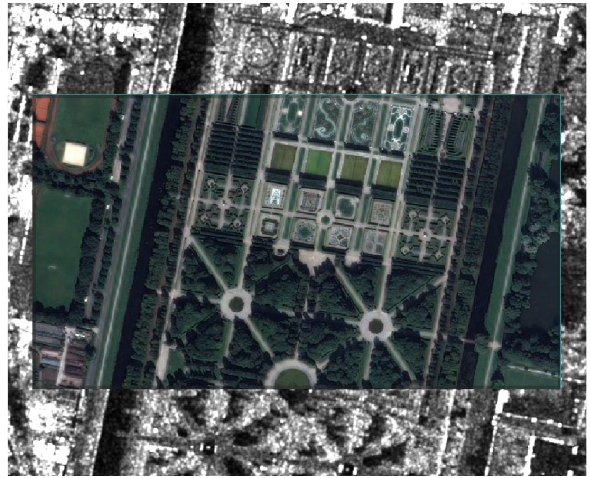
Figure 3. Pléiades-1a registration preview on TerraSAR-X SpotLight image, Hannover, Great Garden. © CNES 2012, Distribution Astrium Services / Spot Image S.A., France, all rights